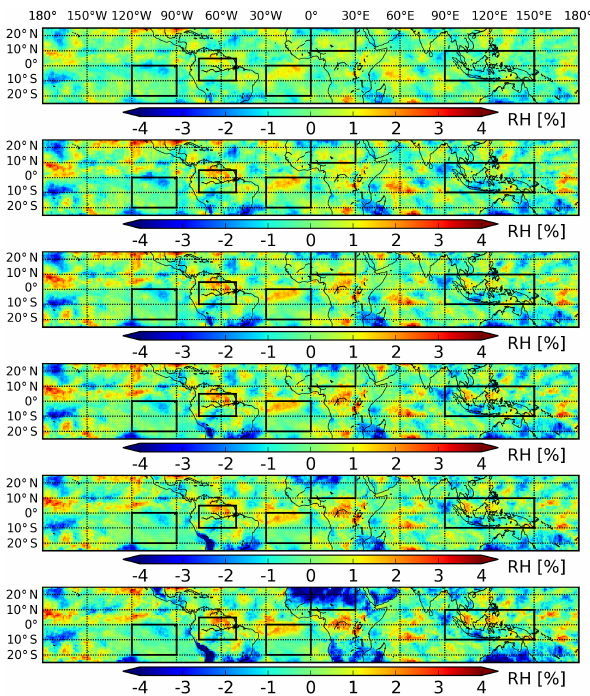
Figure 8. Mean difference of daily average of RH I calculated using only data from 01:30/13:30 local time and the daily average cal- culated using all hourly data. Depicts from top to bottom are for SAPHIR channels 1–6, respectively.